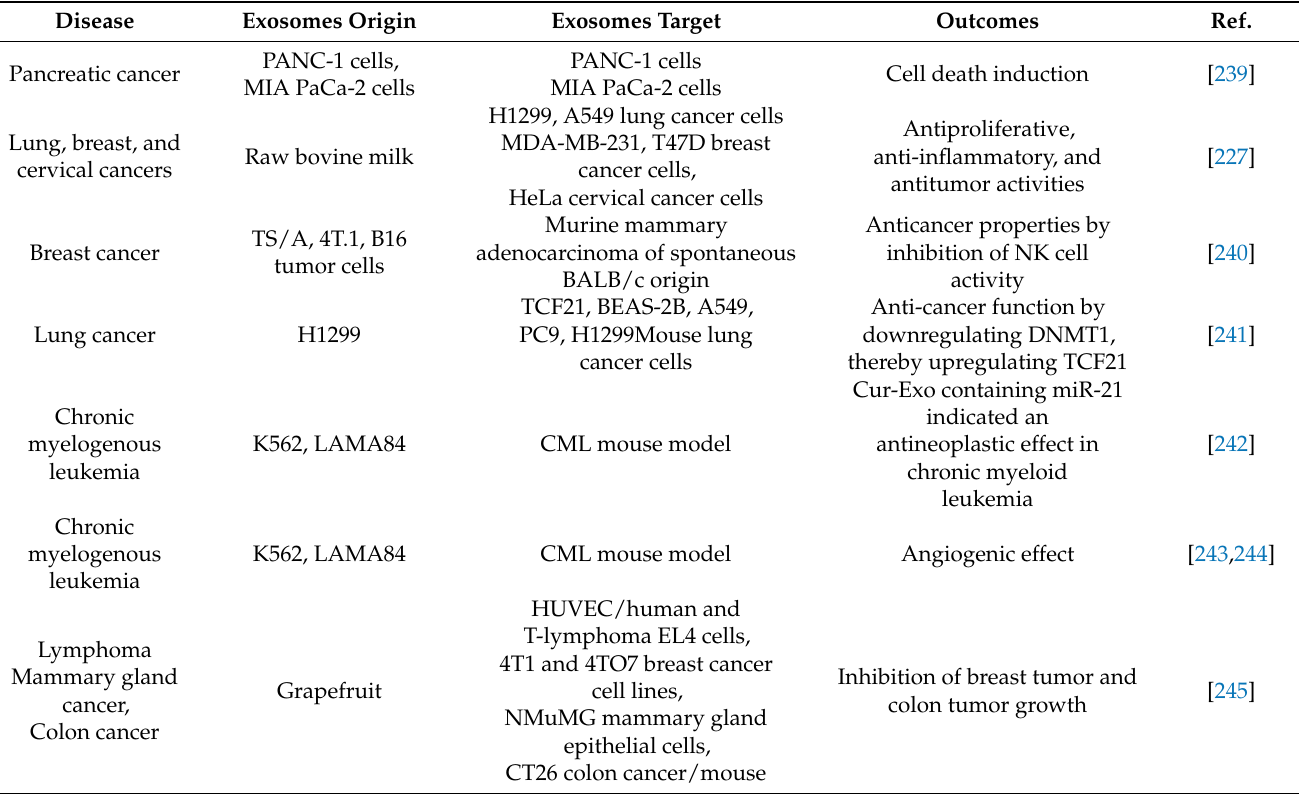
Table 8. In vitro studies on exosomes encapsulated curcumin effect in